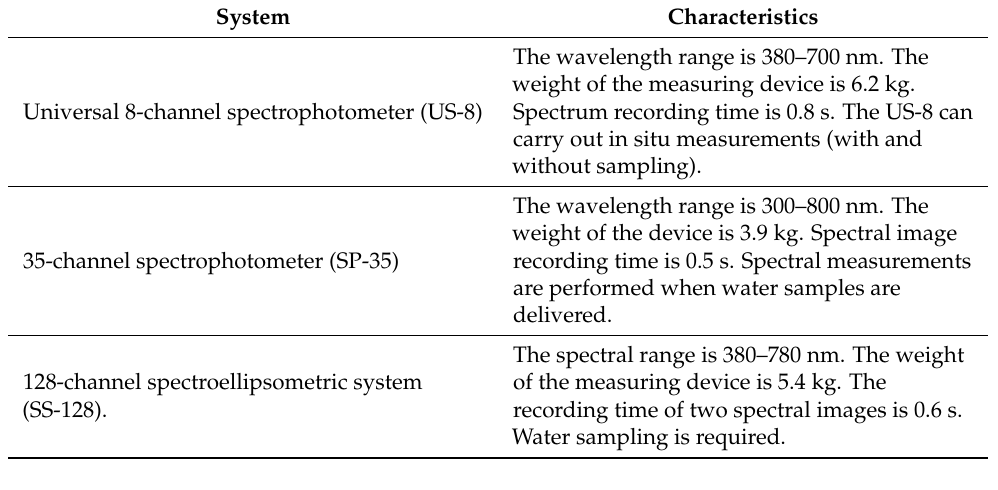
Table 1. Characteristics of the spectral optical systems used in the study of the Angara/Yenisei River system.